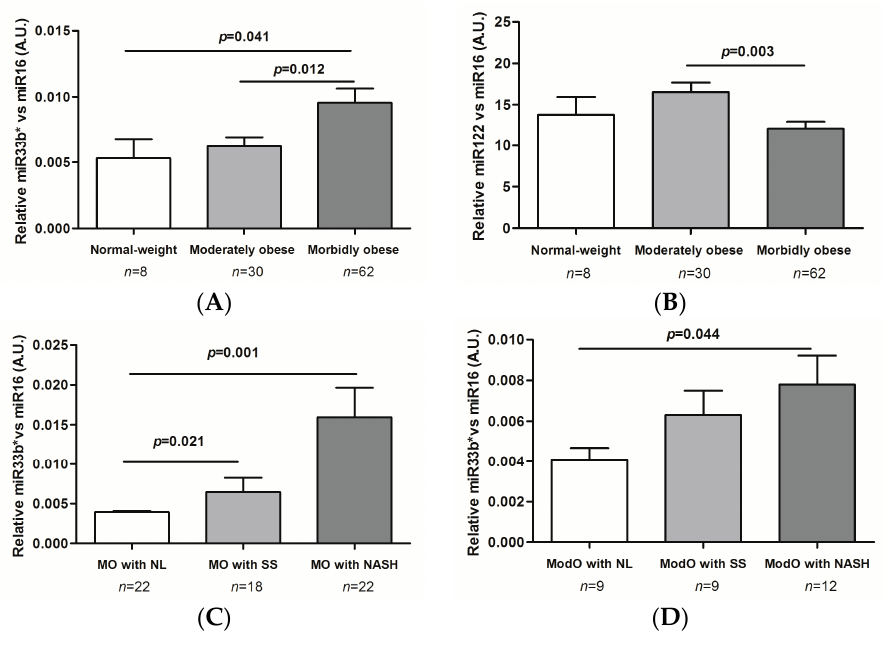
Figure 1. miRNA liver expression according to obesity degree and liver histology. ( A ) Differential expression of miR33b* ; and ( B ) miR122 depending on the degree of obesity; ( C ) miR33b* liver expression in morbidly; and ( D ) moderately obese patients according to liver histology. Morbidly obese (MO) patients with normal liver (NL) ; MO patients with simple steatosis (SS) ; MO patients with nonalcoholic steatohepatitis (NASH) ; Moderately obese (ModO) patients with NL ; ModO patients with SS; ModO patients with NASH; AU, arbitrary units. One-way ANOVA was used to compare the gene expression between groups. Results are shown as the mean ± SEM. p < 0.05 is considered statistically significant.